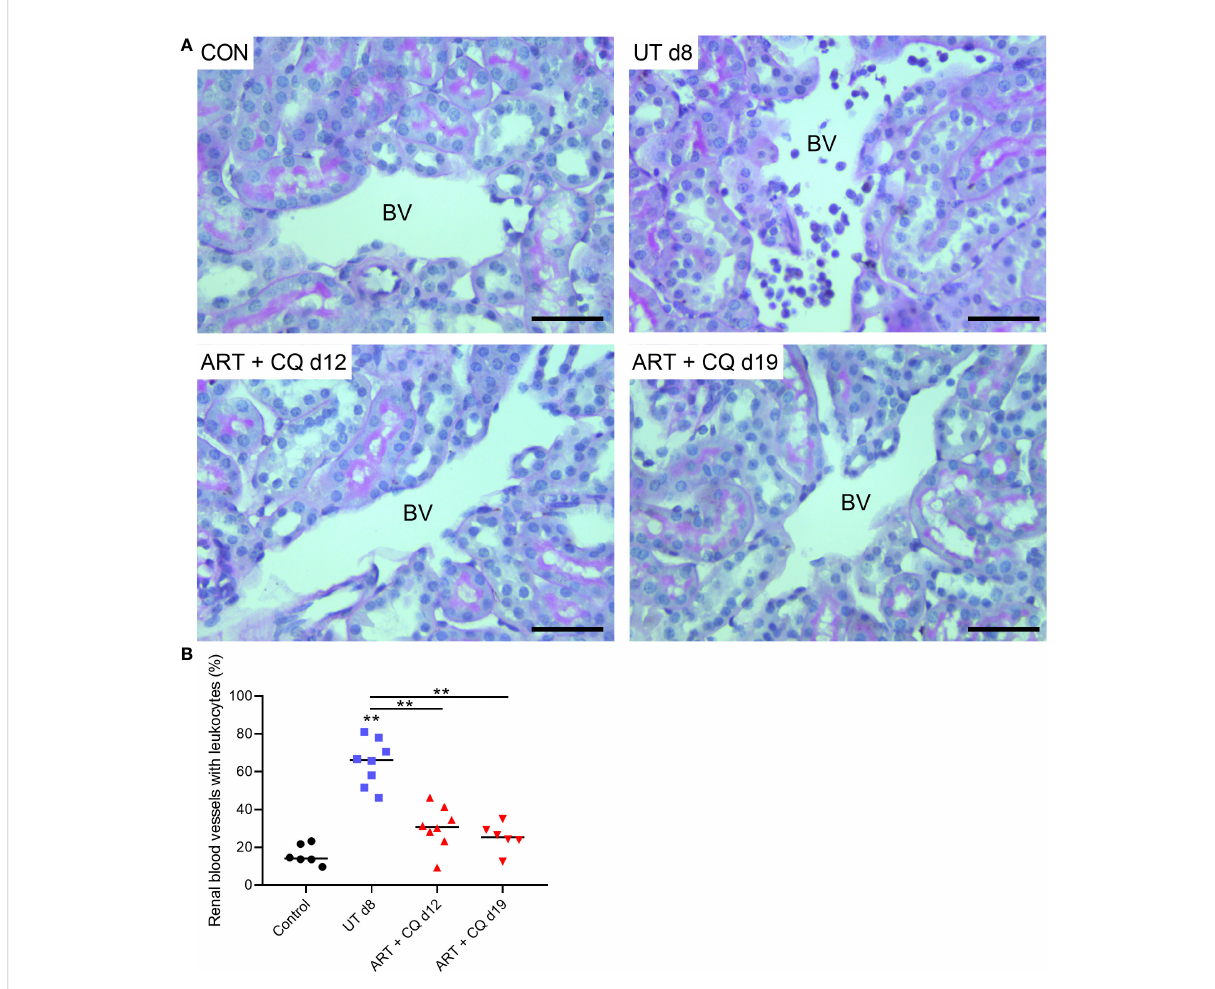
FIGURE 3 Antimalarial treatment decreased intravascular accumulation of leukocytes in kidneys of Pb NK65-E infected mice. C57BL/6 mice were infected with Pb NK65-E parasites and at day 8 p.i. kidneys were dissected. C57BL/6 mice infected with Pb NK65-E were treated from day 8 to day 12 p.i. with antimalarial drugs (ART + CQ) and at day 12 and 19 p.i. mice were dissected. Kidney sections were stained with PAS. (A) Representative images are shown (original magni fi cation x40, bar = 50 µm). BV indicates blood vessel on renal section. (B) Percentage of renal blood vessels with intravascular accumulation of leukocytes Asterisks above data points indicate signi fi cant differences compared to control mice, asterisks above a horizontal line show signi fi cant differences between different time points, **p < 0.01. Data of two experiments, Control: n = 6, untreated Pb NK65-E infected mice (UT) d8: n = 8, ART+CQ d12: n = 8, ART+CQ d19: n =